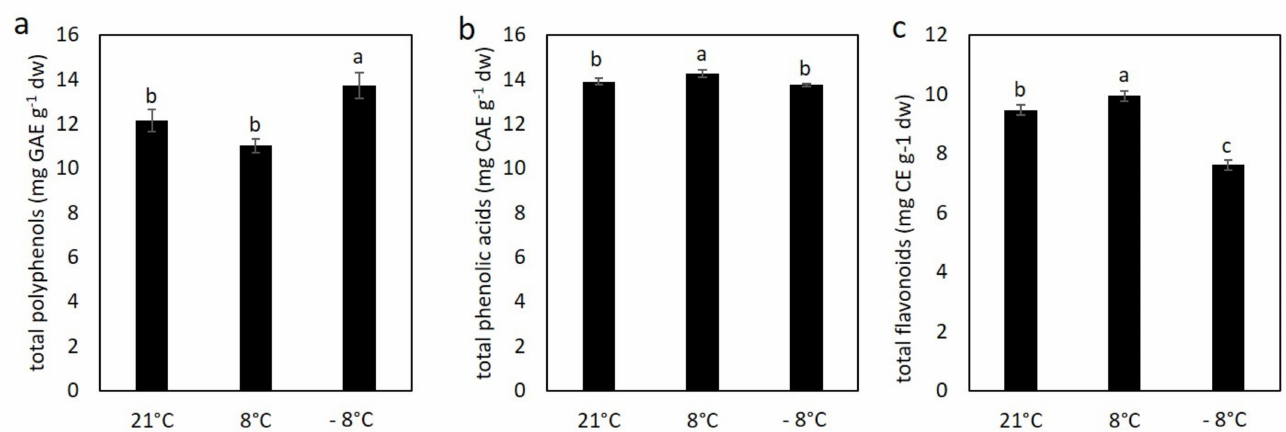
Figure 5. The content of total polyphenols ( a ), total phenolic acids ( b ) and total flavonoids ( c ) in kale exposed to low temperatures. Value marked with different letters are significantly different at p <